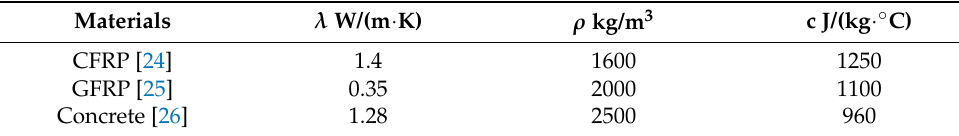
Table 5. Thermodynamic parameters of materials.